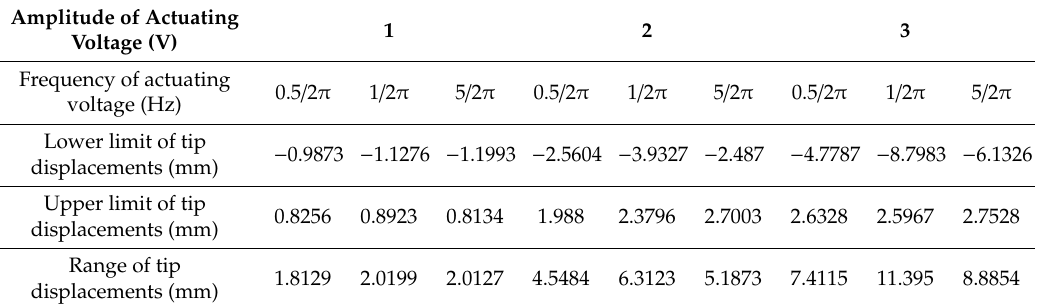
Table 1. IPMCtip displacement range comparison